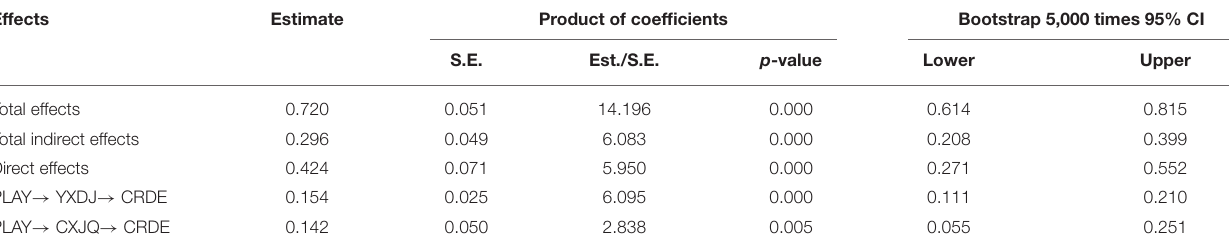
TABLE 11 | Test results of direct effect, indirect effect and total effect.